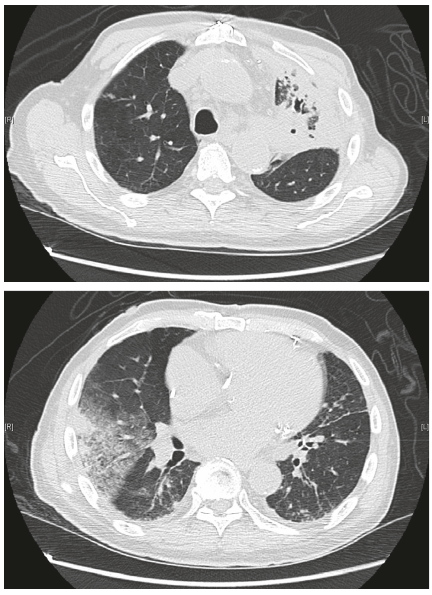
Figure 2: CT chest scan on admission: bronchiectasis and con- solidation in the left upper lobe in addition to peripheral con- solidation in the right upper lobe with adjacent ground-glass